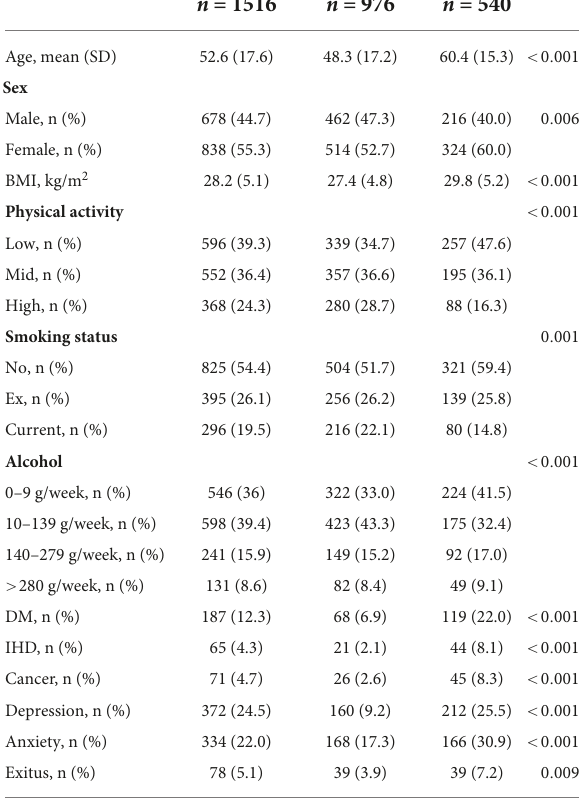
TABLE 1 Sociodemographic, lifestyle, and comorbidities for the overall sample and for good and poor self-rated